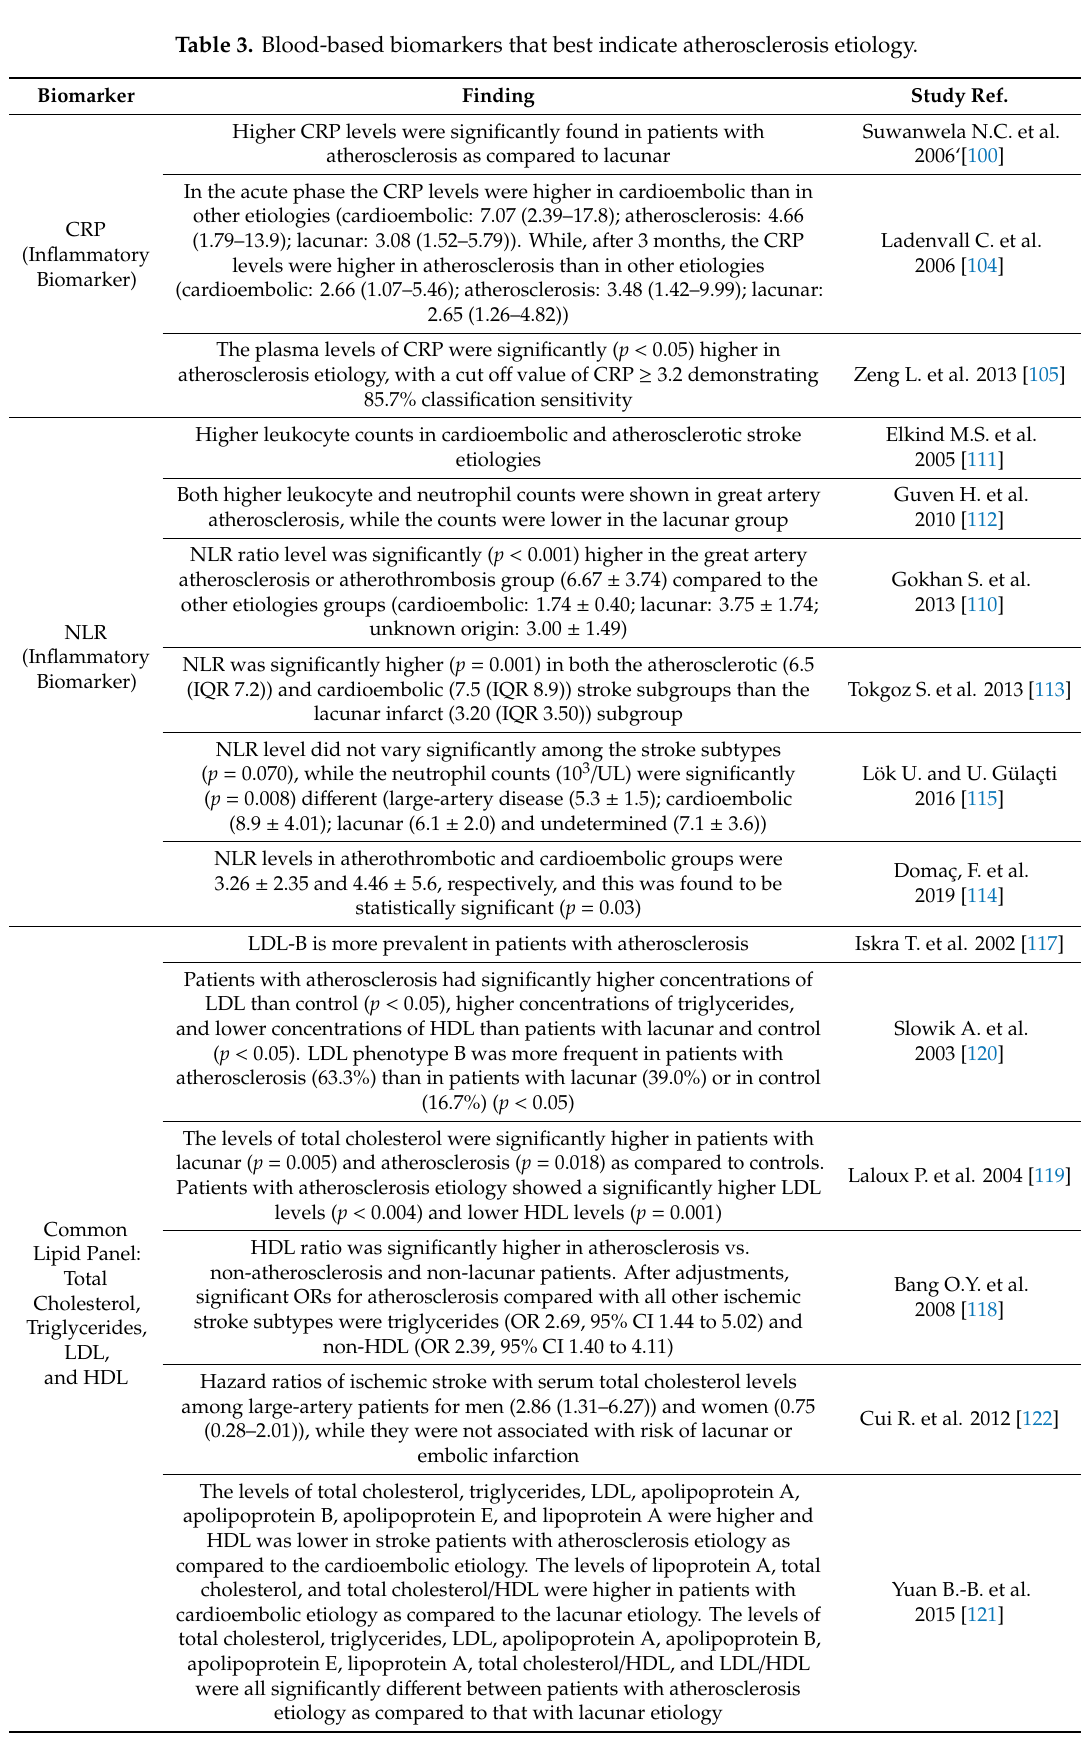
Table 3. Blood-based biomarkers that best indicate atherosclerosis